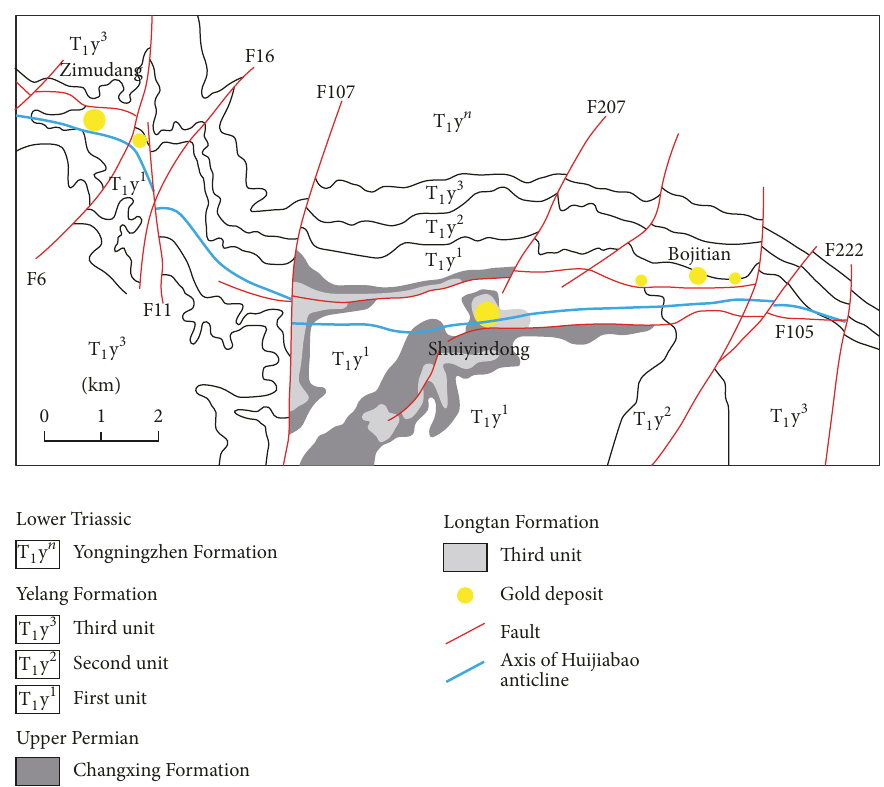
Figure 2: Geological sketch map of the Huijiabao gold field in southwestern Guizhou Province (modified after [40]).